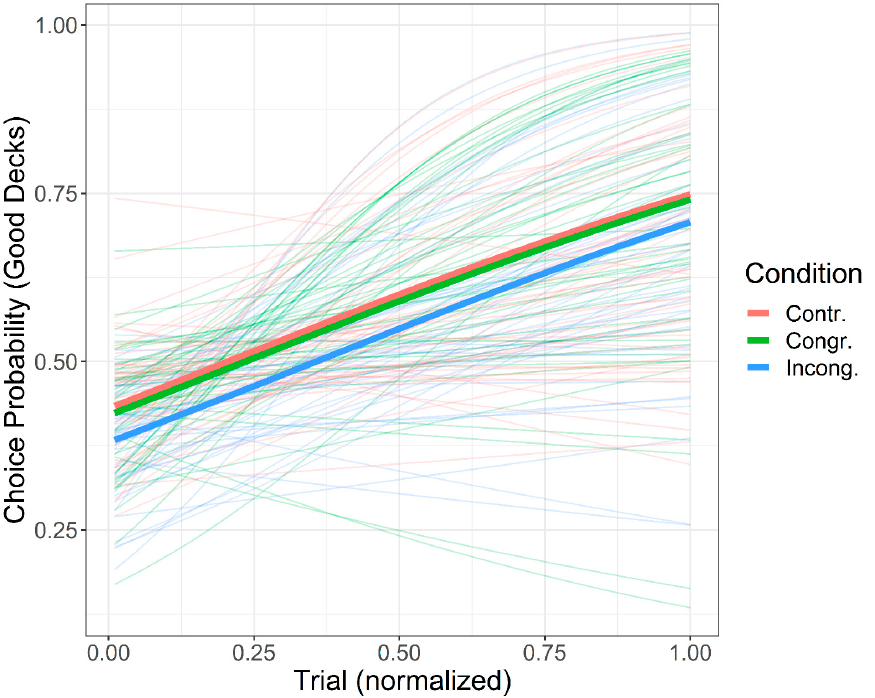
Figure 2. Probability of selecting Good decks as a function of the trial unfolding in the three experimental conditions. Strong and soft lines represent the probability of selecting Good decks at a group-level (fixed-effect) and at the individual-level (random-effects). Choice probabilities are reconstructed by applying an inverse transformation on the logits.